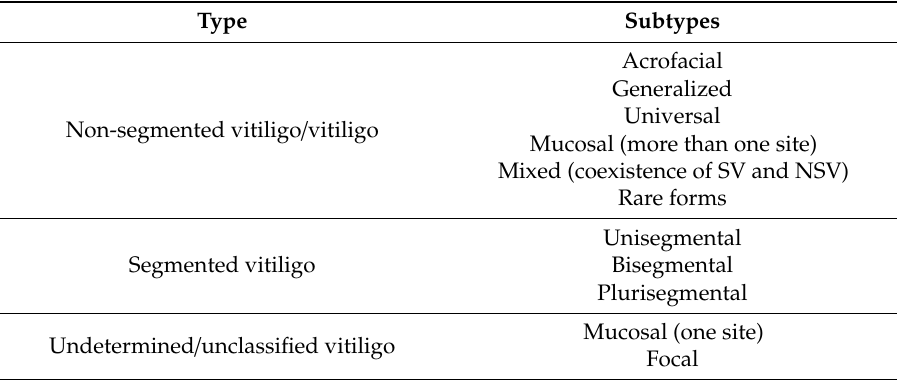
Table 1. Vitiligo classification (adapted from Ezzedine et al. [20] based on Bordeaux VGICC * classification and consensus